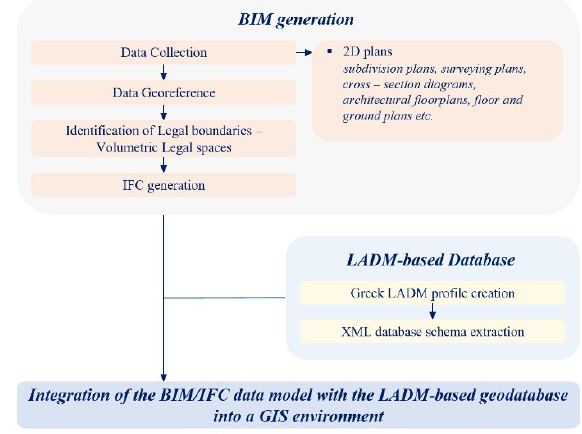
Figure 1. Overview of the proposed methodology